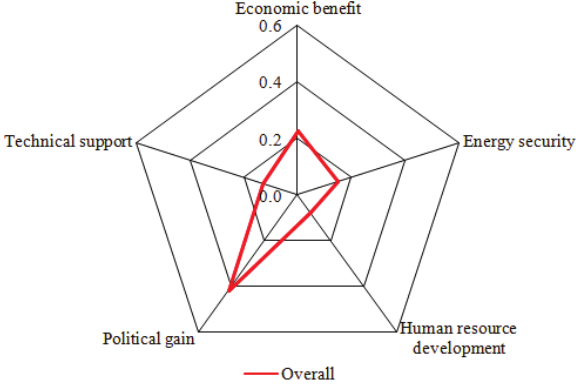
Figure 8. Cumulative responses to A8: “How do you perceive Ban - gladesh’s trilateral nuclear cooperation with India and